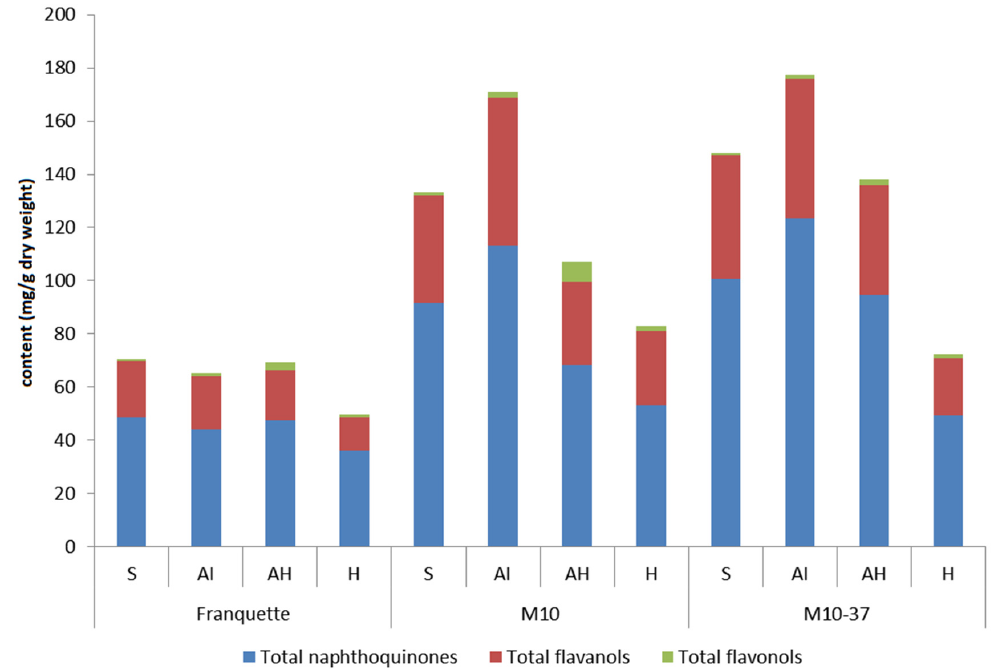
Figure 2. Contents of three major groups of phenolics identified in different severity of walnut anthracnose-affected tissues of J. regia husk, between three cultivars: Susceptible ‘M10-37’, semi-susceptible ‘M10’ and least susceptible ‘Franquette’ (in mg/g dry weight). S: inner spot of infected tissue; AI: outer margin of infected tissue; AH: healthy tissue surrounding the infection; H: healthy tissue.